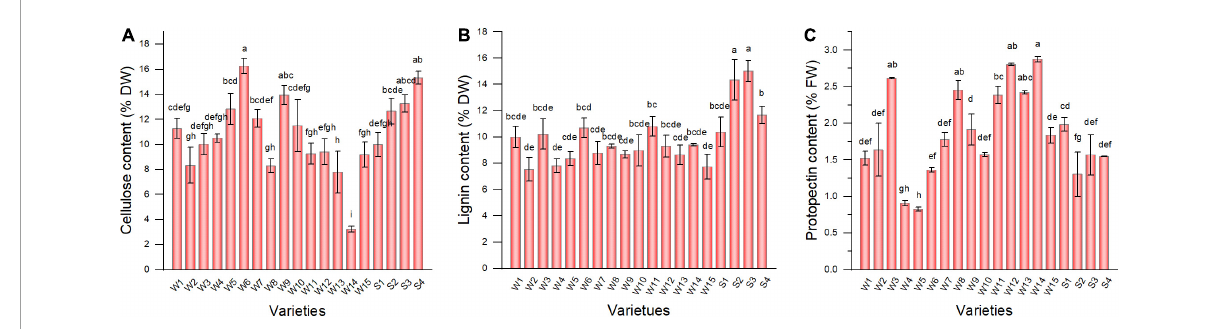
FIGURE2 The cellulose (A) , lignin (B) , and protopectin (C) content of pepper varieties. Data are presented as mean ± SE. Different lowercase letters indicate statistical significance according to Duncan’s multiple range test ( p < 0.05). W1, Fengshouxianjiao; W2, Sujiao 8; W3, Qingan 7; W4, Sujiao 18; W5, Longjiao 2; W6, Longjiao 10; W7, Longjiao 11; W8, Huamei 105; W9, 37–124; W10, 3F*106; W11, Tianjiao 20; W12, Tianjiao 23; W13, Hangjiao 2; W14, Hangjiao 8; W15, NO.171; S1, NO.212; S2, NO.221; S3, Sujiao 9; S4,